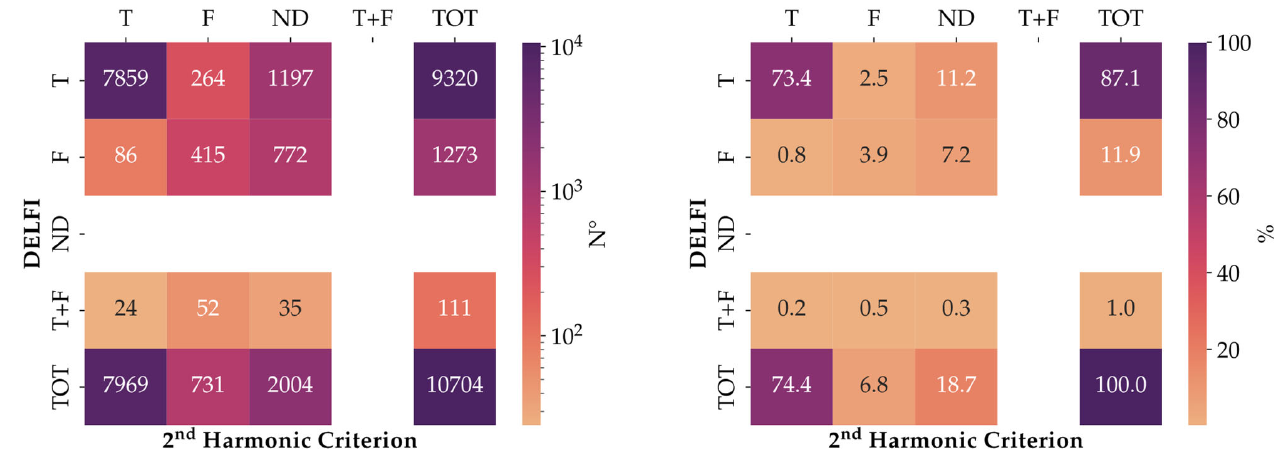
Figure 9. Validity assessment: 2nd Harmonic and DELFI outcomes for the Overall Set.